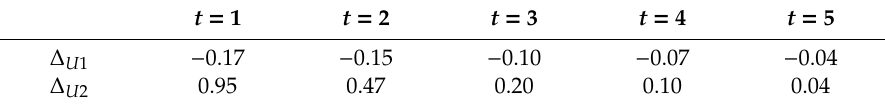
Table 14. Deviational parameters for the cost of electricity.